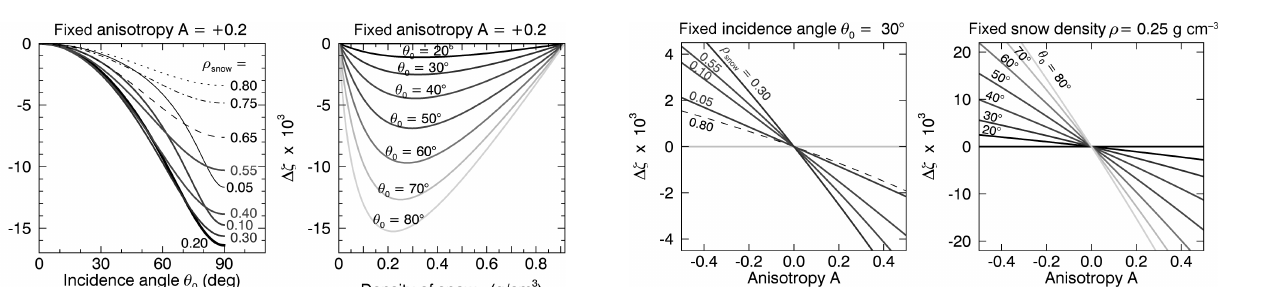
Figure 3. Specific path length difference between V- and H- polarized microwaves ( (cid:49)ζ , Eq. 23) plotted for snow with horizon- tally aligned oblate ice grains ( A =+ 0.2) over incidence angle (left panel) and snow density (right panel).